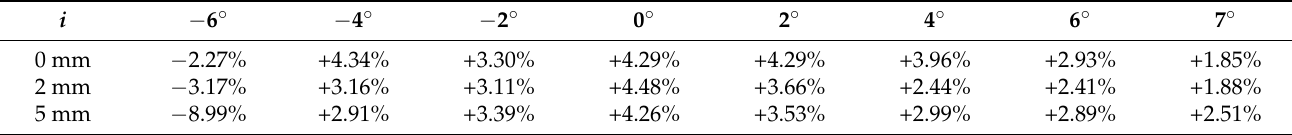
Table 6. The static pressure rise coefficient